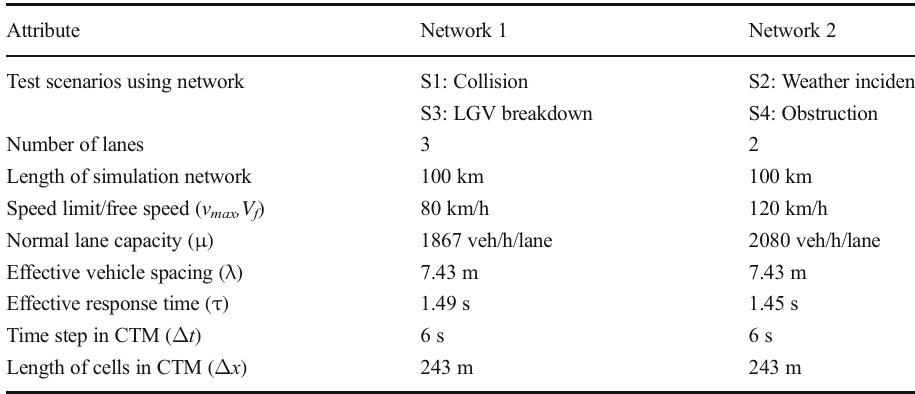
Table 4 Summary of characteristics of test networks